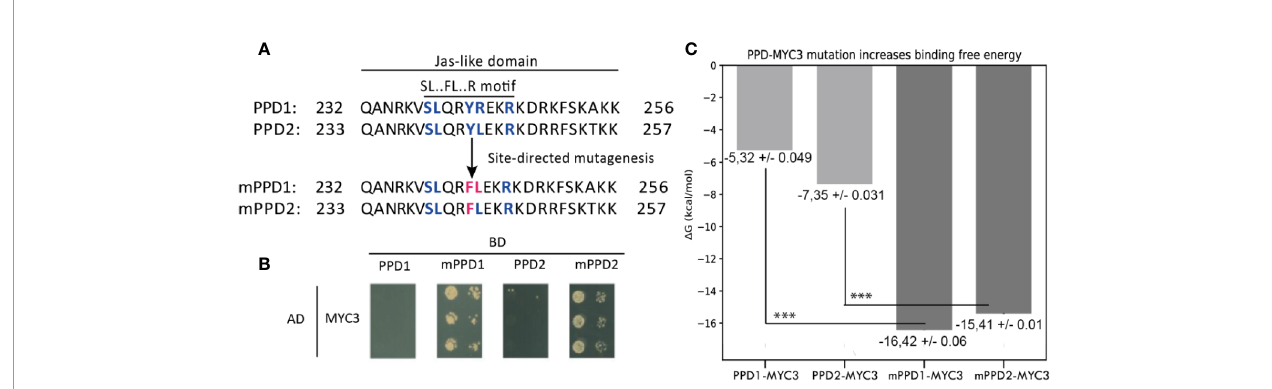
FIGURE 5 | Site-directed mutagenesis assay of PPD-MYC3 complexes. (A) Amino acid alignment showing chances in the Jas-like domain of PPD1, PPD2, and mutants mPPD1 and mPPD2. (B) Yeast-two hybrid experiments are showing the favorable change in af fi nity upon mutation of the SL.FL.R motif in PPD1 and PPD2. (C) Predicted free binding energy of PPD1, PPD2, and mPPD1, mPPD2 mutants. Triple asterisks show statistical signi fi cance (p < 0.05) between wild type and